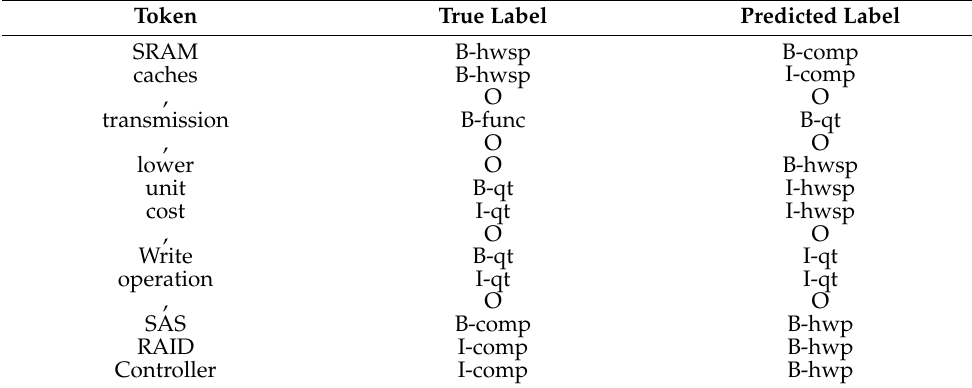
Table 8. Failed predictions on test data.